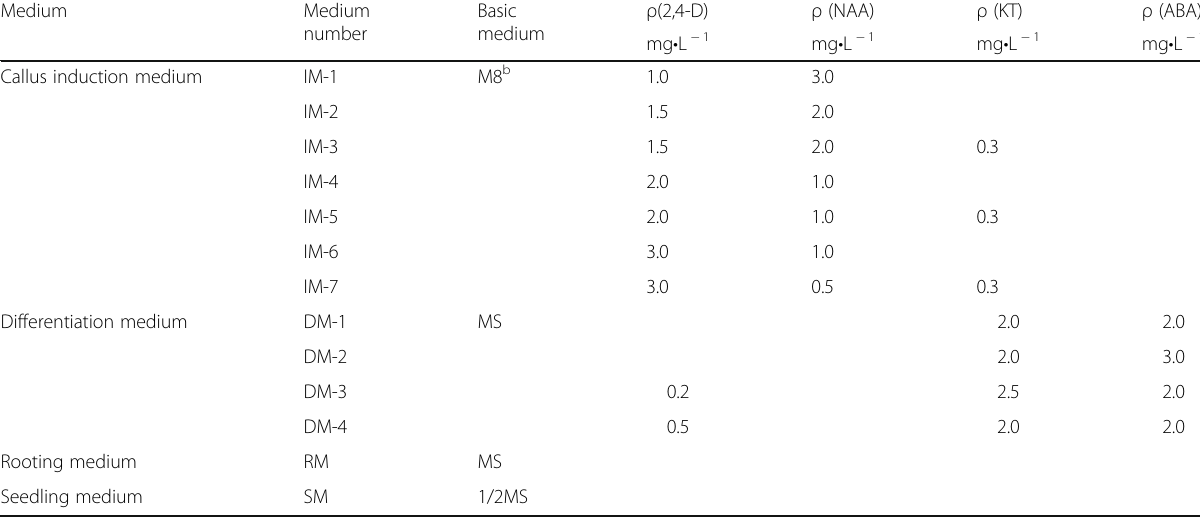
Table 1 Plant hormone components in the callus induction, differentiation, and rooting media a